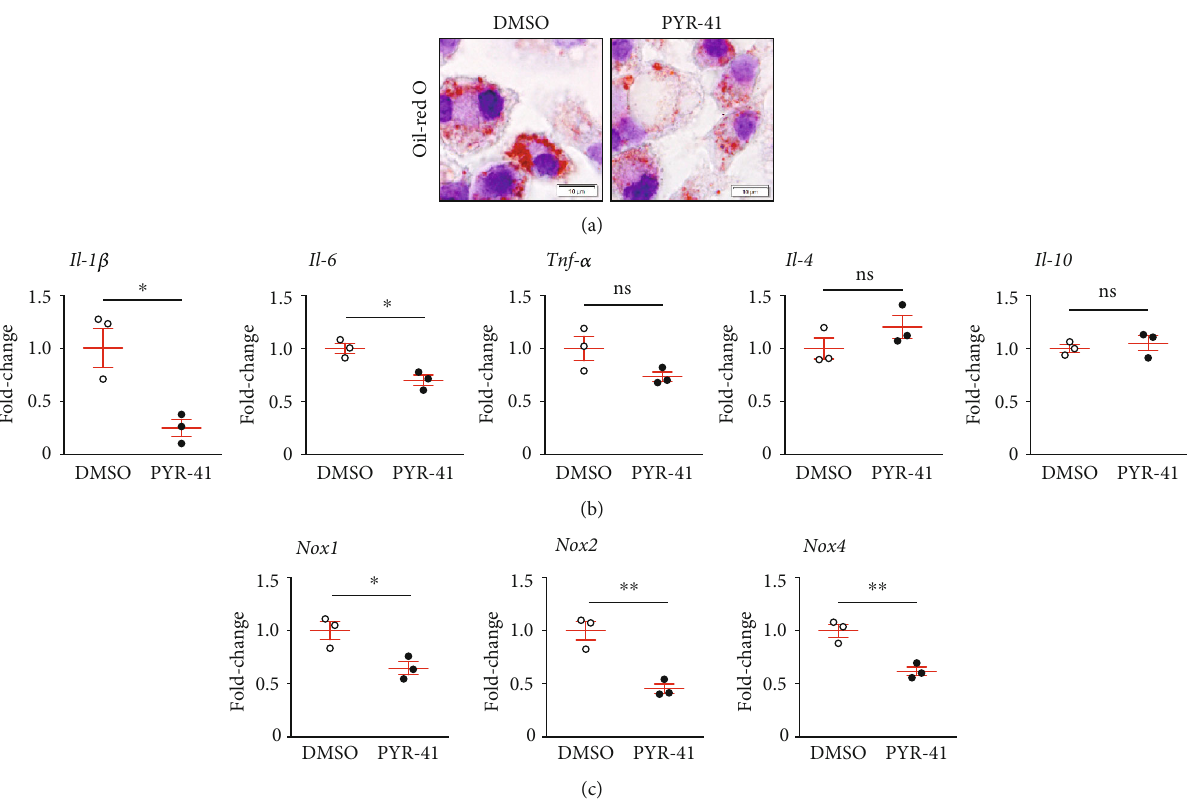
Figure 6: Inhibition of UBA1 blunted ox-LDL-induced lipid accumulation and expression of proin fl ammatory cytokines and NADPH oxidases in cultured macrophages. (a) Oil red O staining of ox-LDL-treated RAW264.7 cells. (b) Quantitative real-time PCR analysis of proin fl ammatory ( Il-1 β , Il-6 , and Tnf α ) and anti-in fl ammatory ( Il-4 and Il-10 ) cytokine expression in ox-LDL-treated RAW264.7 cells. (c) Quantitative real-time PCR analysis of NADPH oxidase ( Nox1 , Nox2 , and Nox4 ) expression in ox-LDL-treated RAW264.7 cells. n = 3 per group; ∗ : < 0.05; ∗∗ : < 0.01; ns: not signi fi